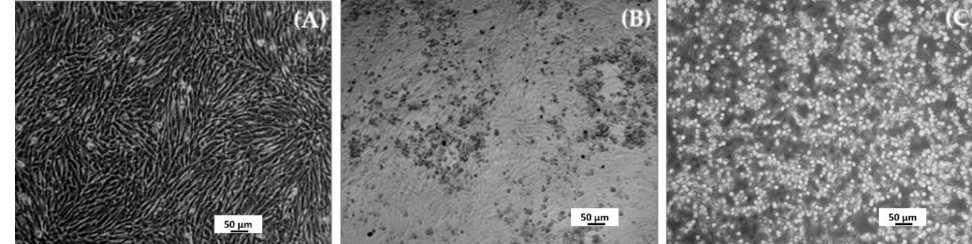
Figure 2. Photograph of Vero E6 cultures. ( A ) mock infected (control) culture evidencing a monolayer of adherent cells; ( B , C ) cultures infected with mengovirus, evidencing cytopathic effect (CPE): ( B ) early CPE (foci of infection), ( C ) complete CPE (rounded detached cells).